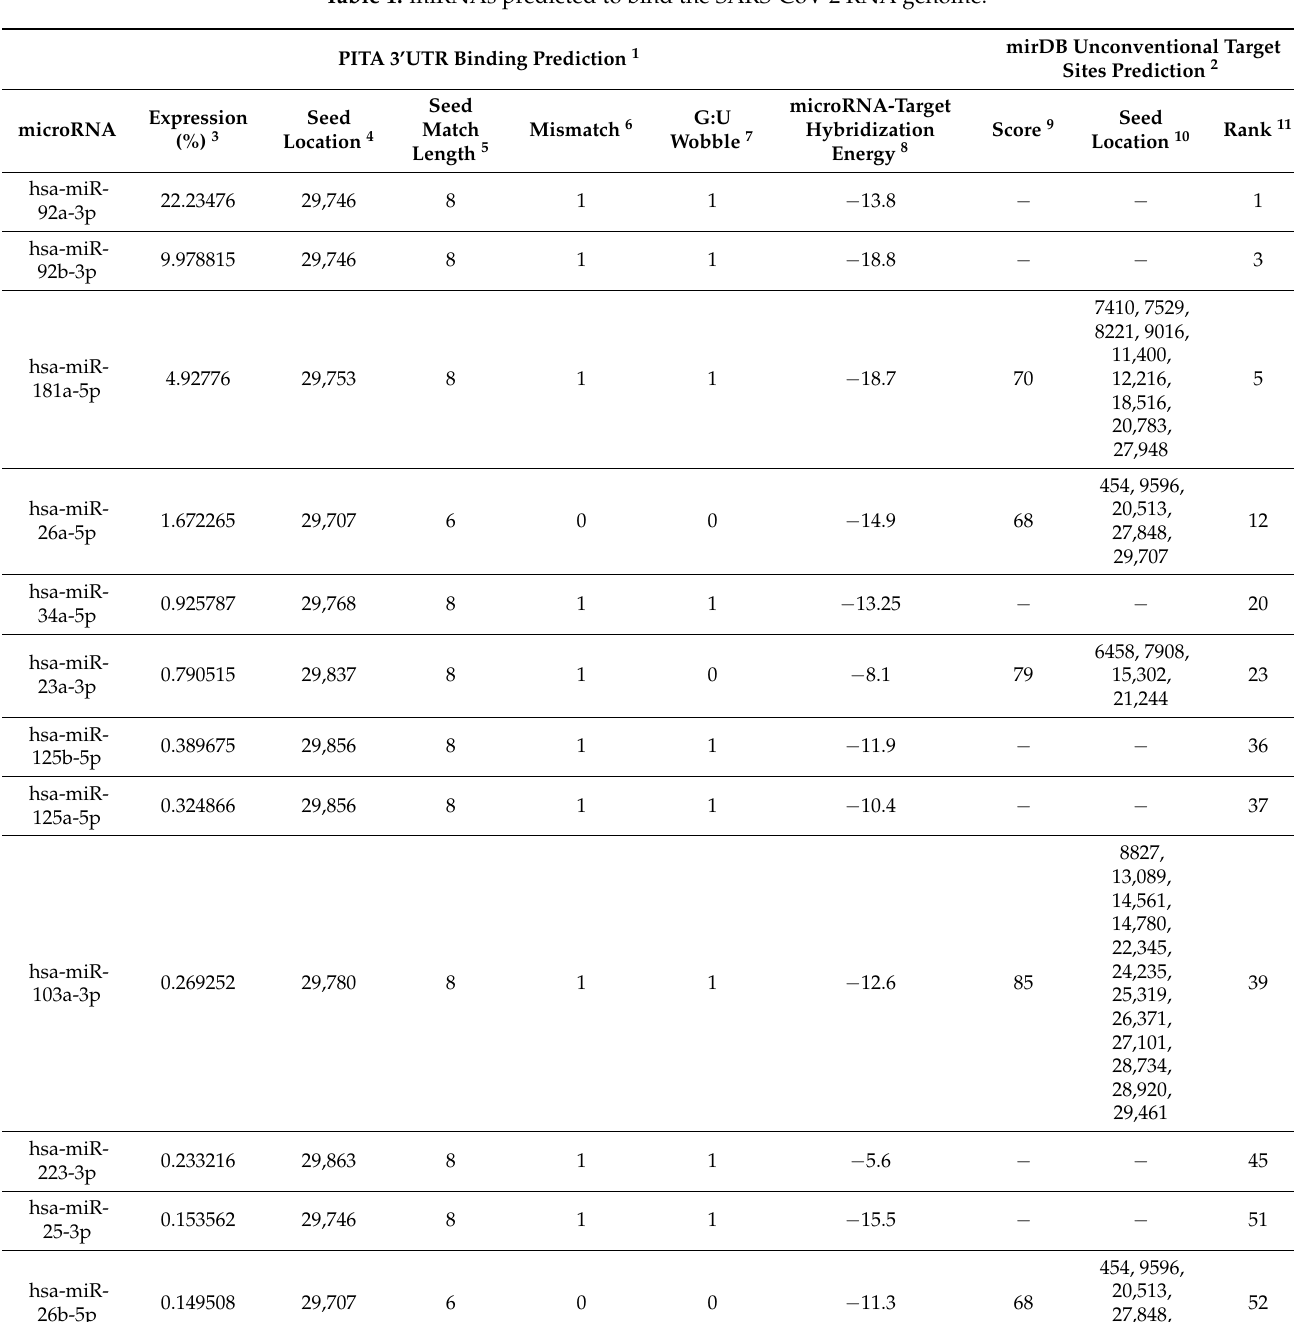
Table 1. miRNAs predicted to bind the SARS-CoV-2 RNA